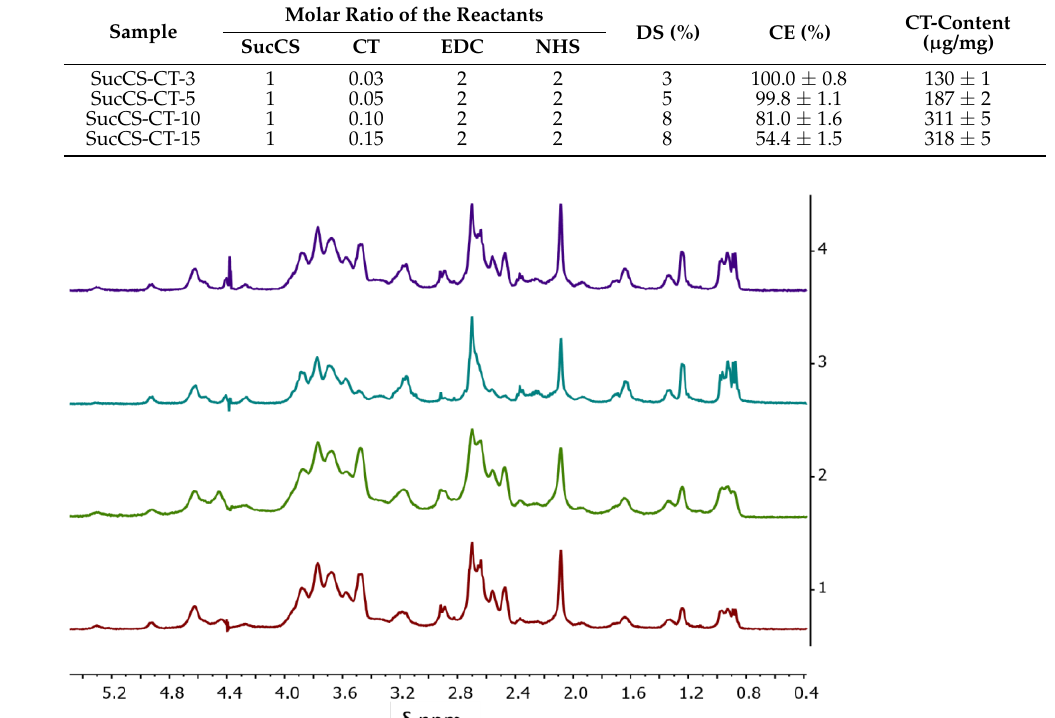
Table 1. Condition for synthesis and characterization of succinyl chitosan-colistin conjugate (SucCS- CT).